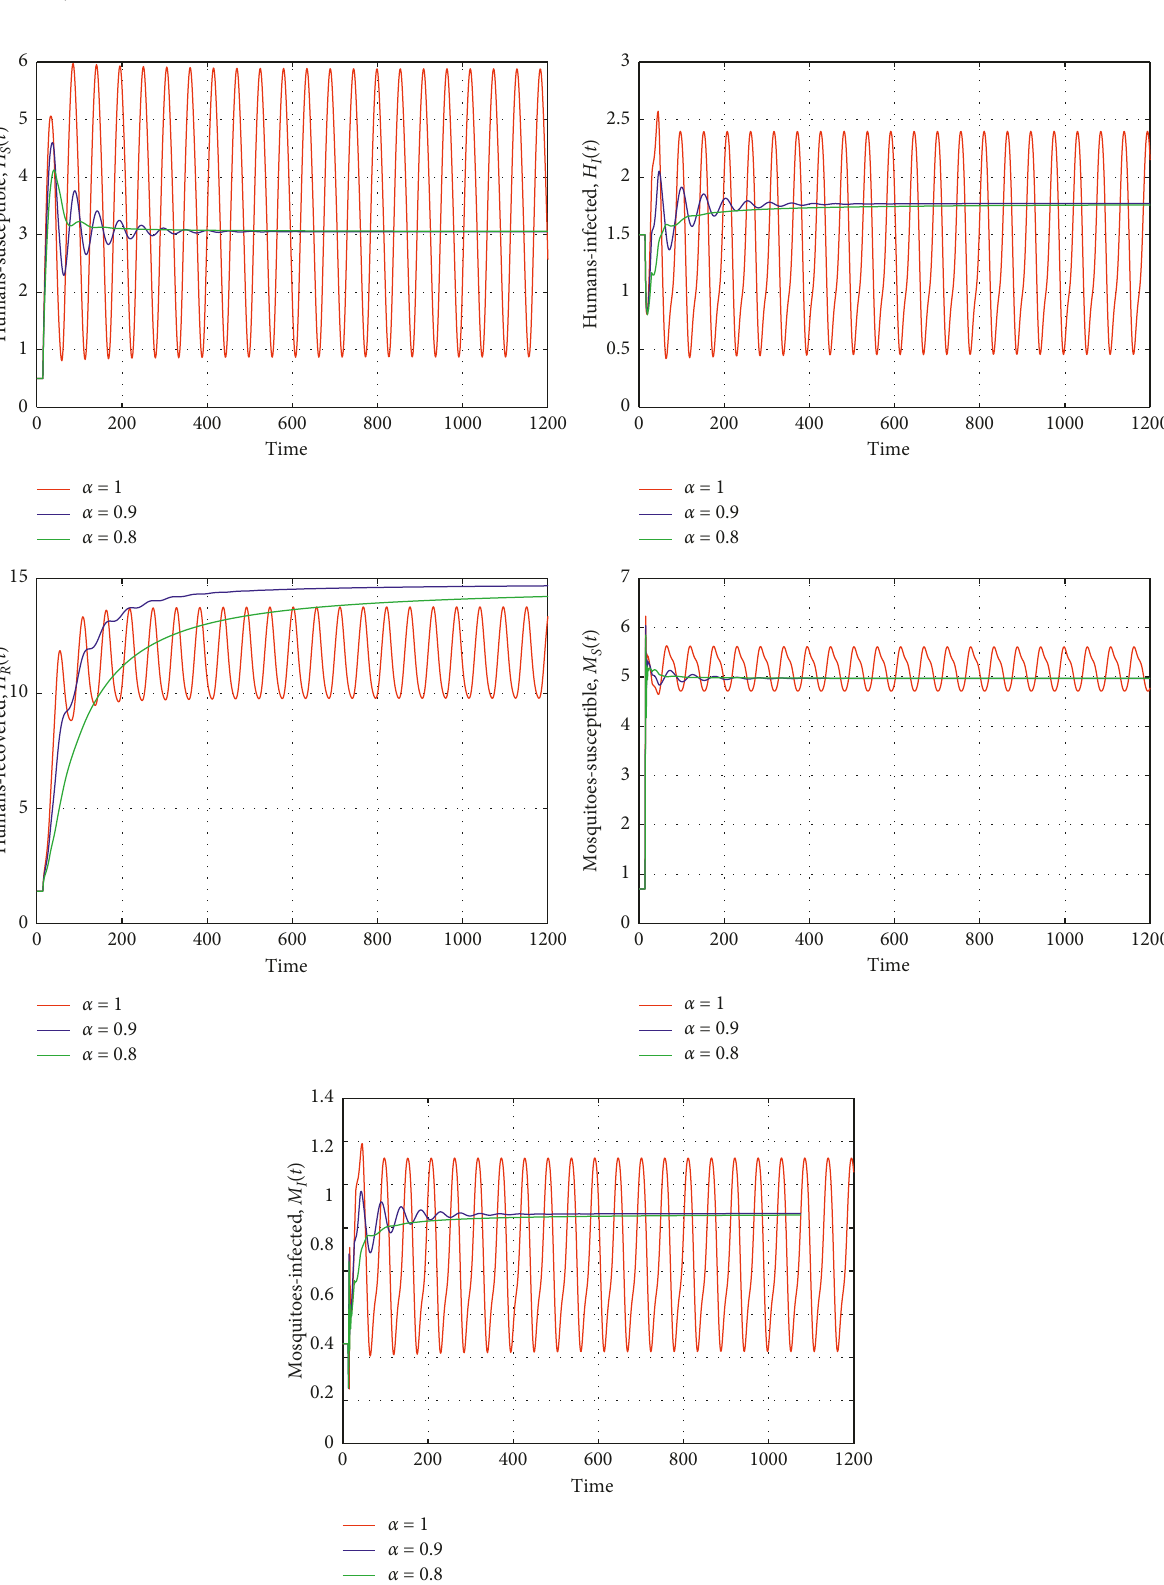
� 0 . 0 , τ � 14 , and τ 1 2 < τ ∗ with α � 0 . 9and 0 . 8, it is asymptotically stable (blue and green 2 2